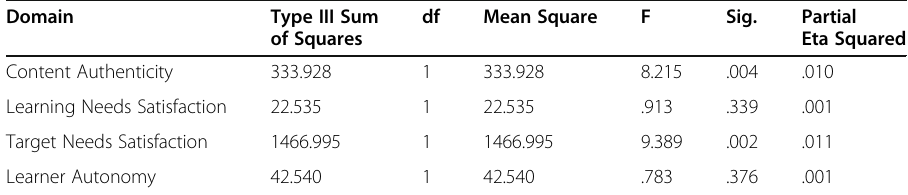
Table 7 Results of between-subjects tests on the four attitudinal domains